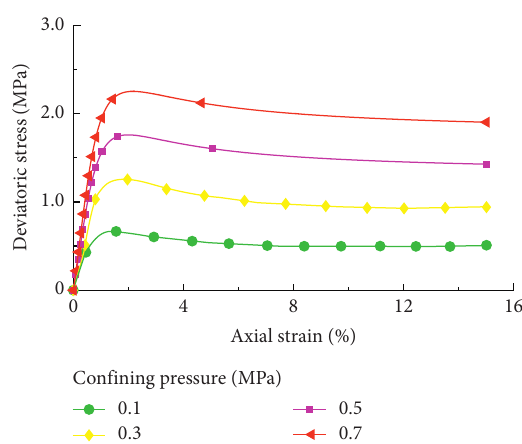
Figure 18: Deviatoric stress-axial strain relationships for stabilized soils with different confining pressure (stabilizer content � 5%; curing time � 3 days).